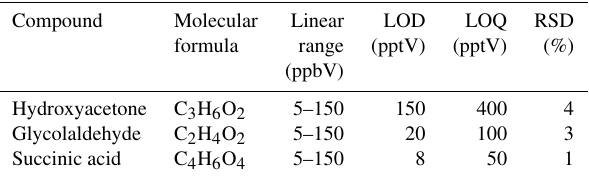
Table 4. Analytical performances for the determination of hydroxyl carbonyl and carboxylic acid model